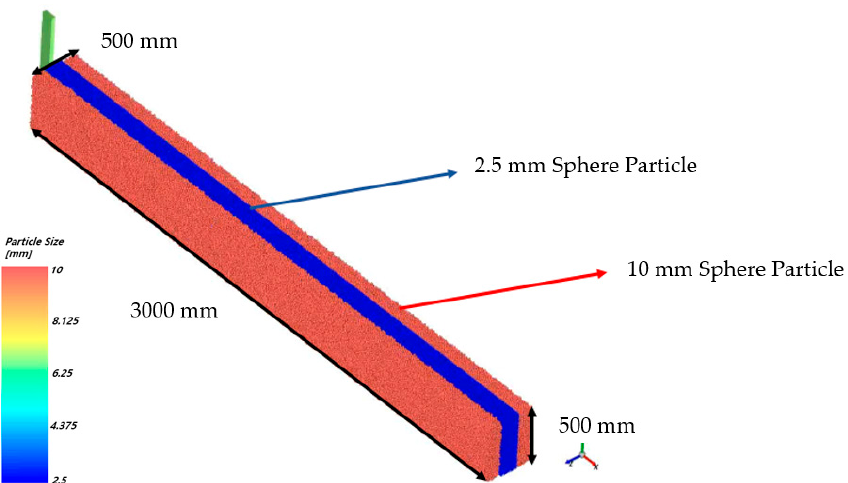
Figure 6. Apparatus of wear part and particle domain.